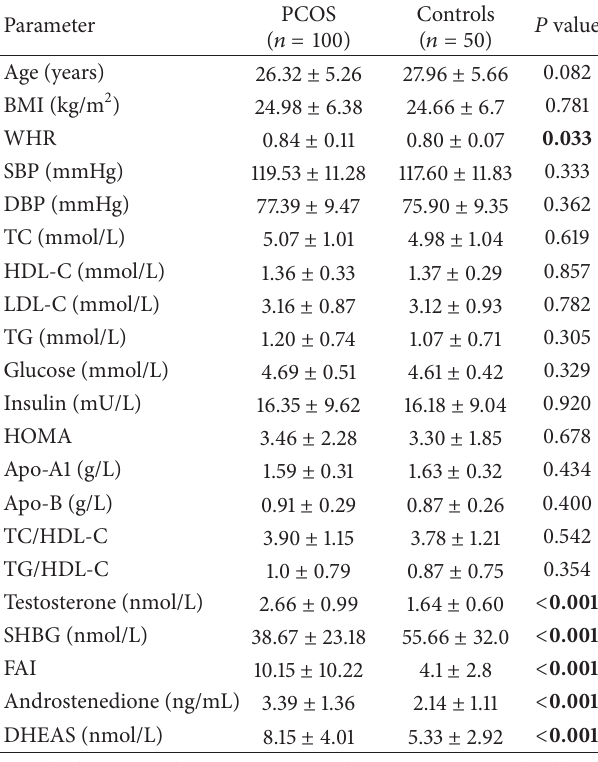
Table 1: Clinical and biochemical parameters in women with PCOS and